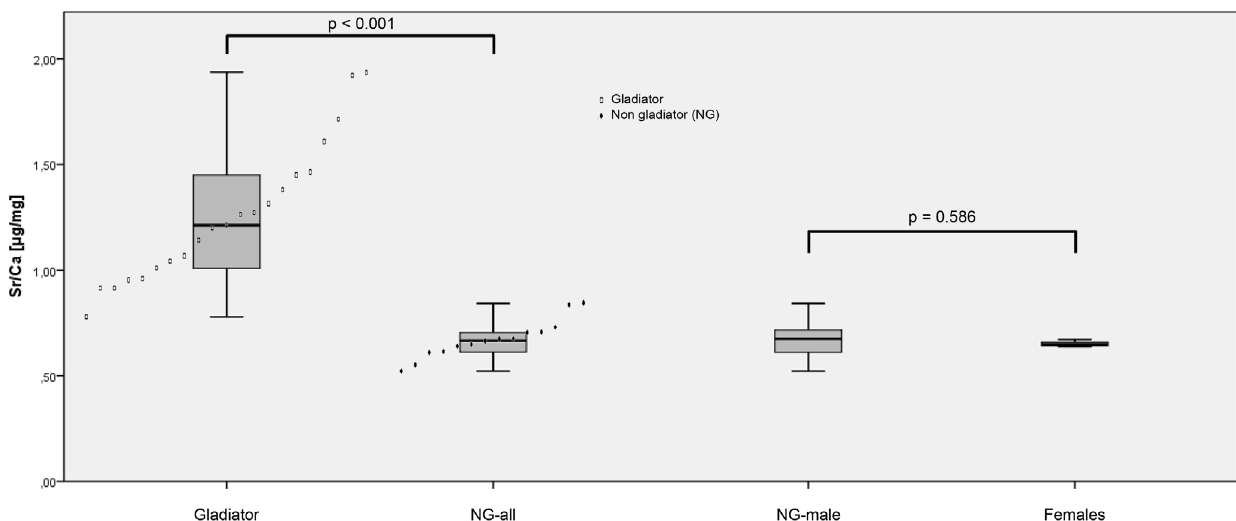
Figure 5. Sr/Ca ratios. Individual values and comparison between different groups (gladiators, NG-all, NG-males, and females).